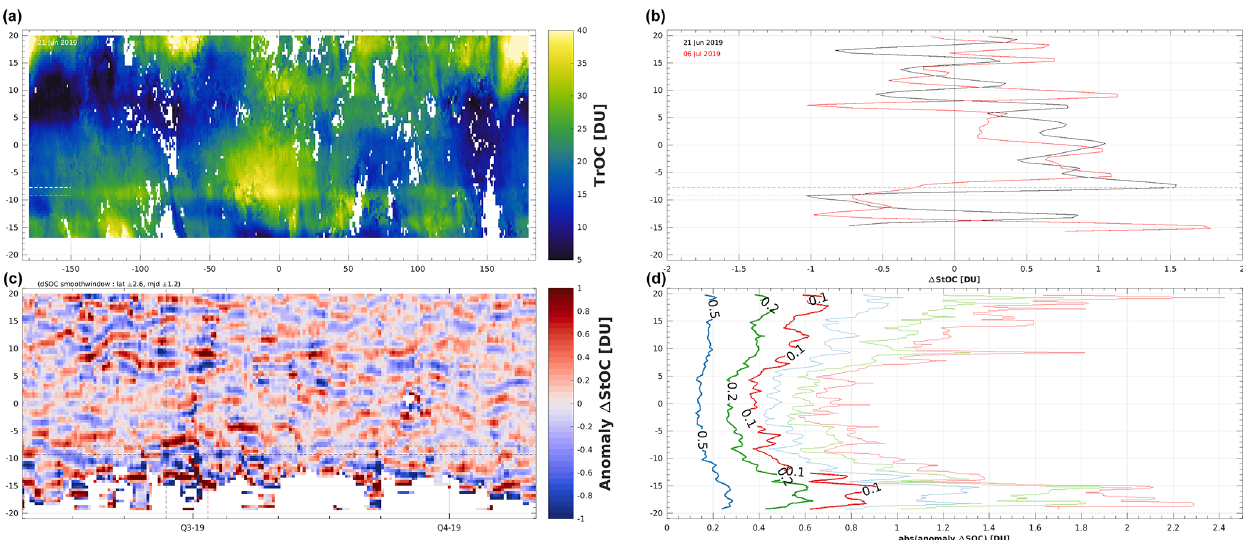
Figure 10. (a) Example of banded structure around 10 ◦ S in the TROPOMI TrOC map of 21 June 2019. (b) Meridian gradient of StOC for 2d in 2019 ( (cid:49) StOC). (c) Anomaly of (cid:49) StOC with respect to latitude- and time-smoothed (cid:49) StOC (May–October 2019). (d) Cumulative distribution function of the absolute value of (cid:49) StOC anomaly (thin lines correspond to 5%, 2% and 1%